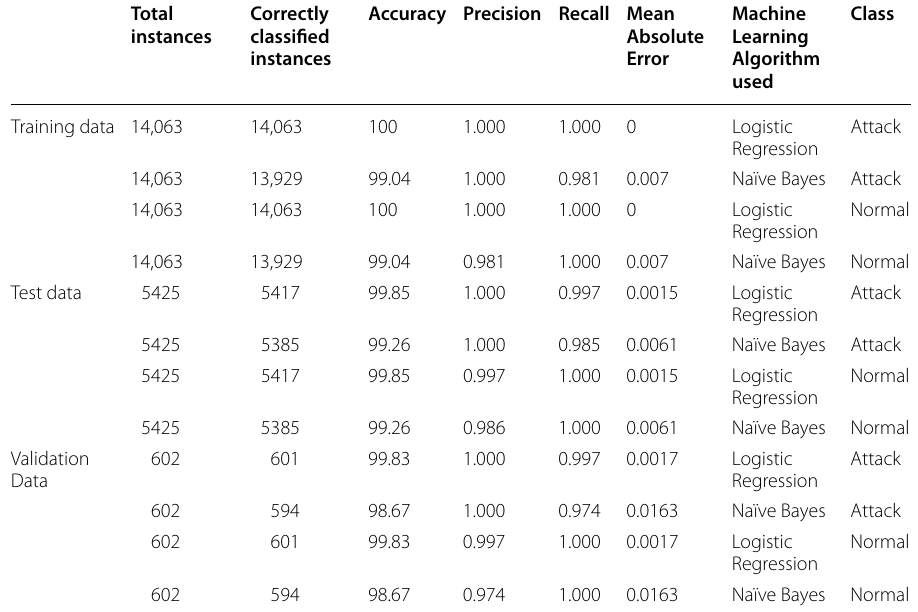
Table 6 Summary of the results for the experimental model